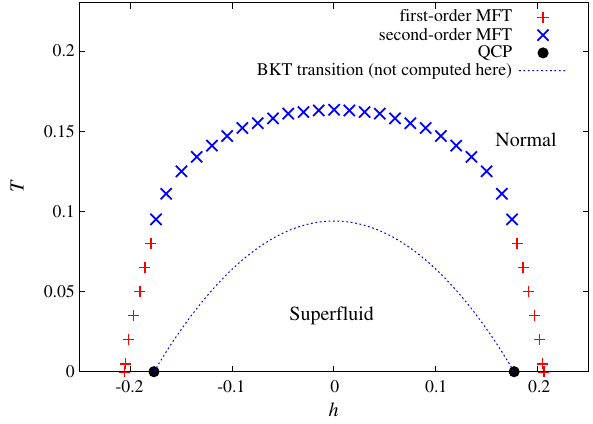
FIG. 3. Fluctuation-corrected phase diagram of imbalanced fermionic superfluids in two dimensions. Goldstone and longi- tudinal fluctuations induce new quantum critical points (black circles) at ð h ¼ (cid:1) 0 . 18 ; T ¼ 0 Þ between a normal Fermi mixture and a Sarma-Liu-Wilczek superfluid with gapless fermions. Toward h → 0 , another transition to a fully gapped superfluid is expected. Furthermore, fluctuations suppress spontaneous symmetry breaking to T ¼ 0 . Extension of our computations to finite T [45] would lead to a BKT transition line connecting the new QCPs [46]. Mean-field theory (MFT) predicts an incomplete picture: a superfluid dome (blue crosses) with long-range order and first-order transitions on its wings (red crosses).